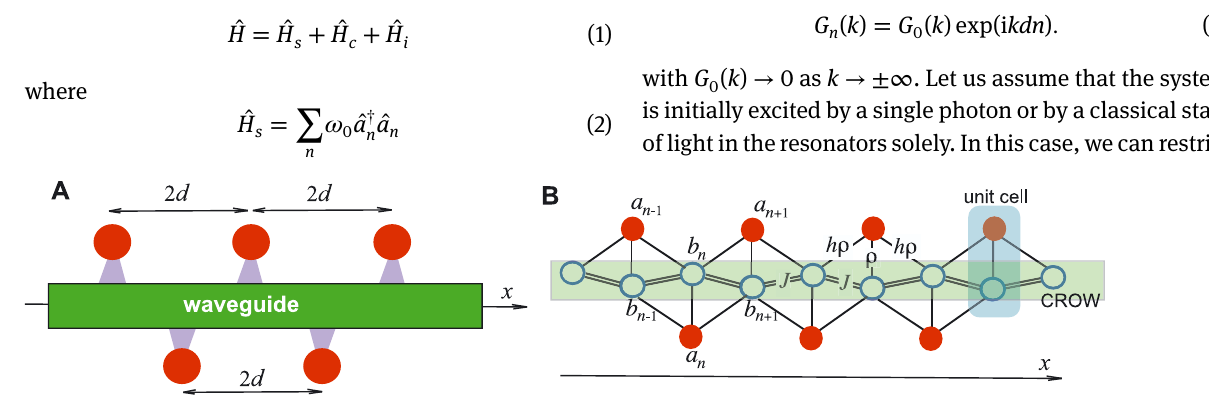
Figure 1: (A) Schematic of a waveguide with N side-coupled optical resonators or cavities ( N = 5 in the figure). Adjacent cavities are spaced by a distance d . (B) A CROW in a zig-zag geometry (blue rings) with side-coupled optical cavities (red circles). The solid bonds show the couplings of the various cavities/resonators. Note that each cavity is coupled to three resonators of the CROW with coupling constants 𝜌 and h 𝜌 . The distance between adjacent cavities is d = 1 (in units of the CROW period). The overall cavities-CROW system can be viewed as a bipartite lattice with two sites in the unit cell (sublattice A formed by the side cavities and the sublattice B formed by the resonators of the CROW). The weak-coupling limit corresponds to 𝜌 ≪ J , where J is the coupling rate of adjacent resonators in the